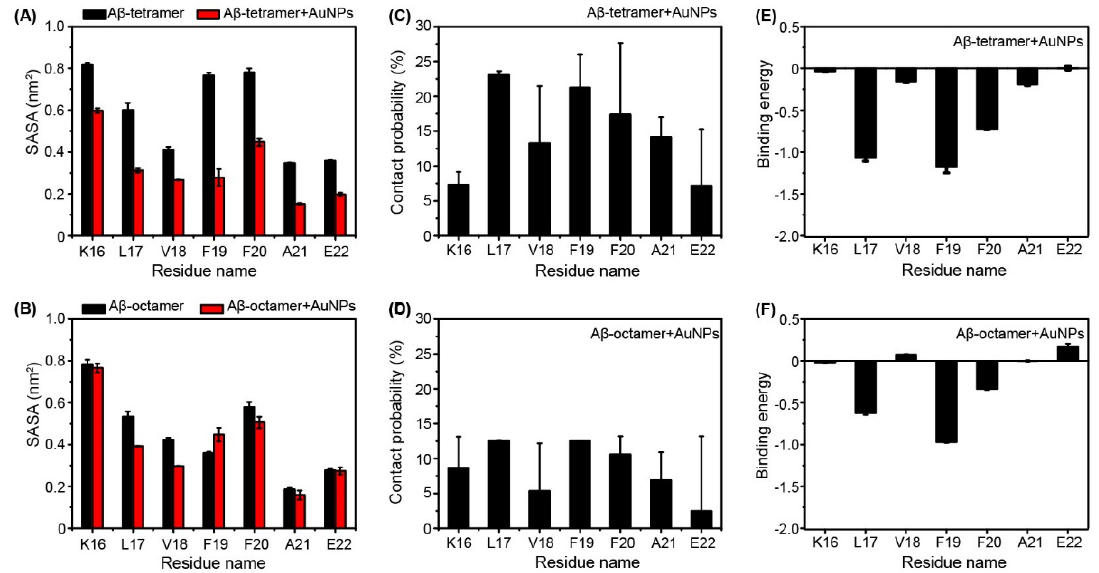
Figure 5. Solvent accessible surface area of each residue as a function of amino acid residue ( A ) for the Aβ tetramer ( B ) and the Aβ octamer in the absence (black) and presence (red) of AuNPs. Residue-based binding interaction analysis: contact probability ( C , D ) and binding free energy (in kcal mol −1 ) ( E , F ).